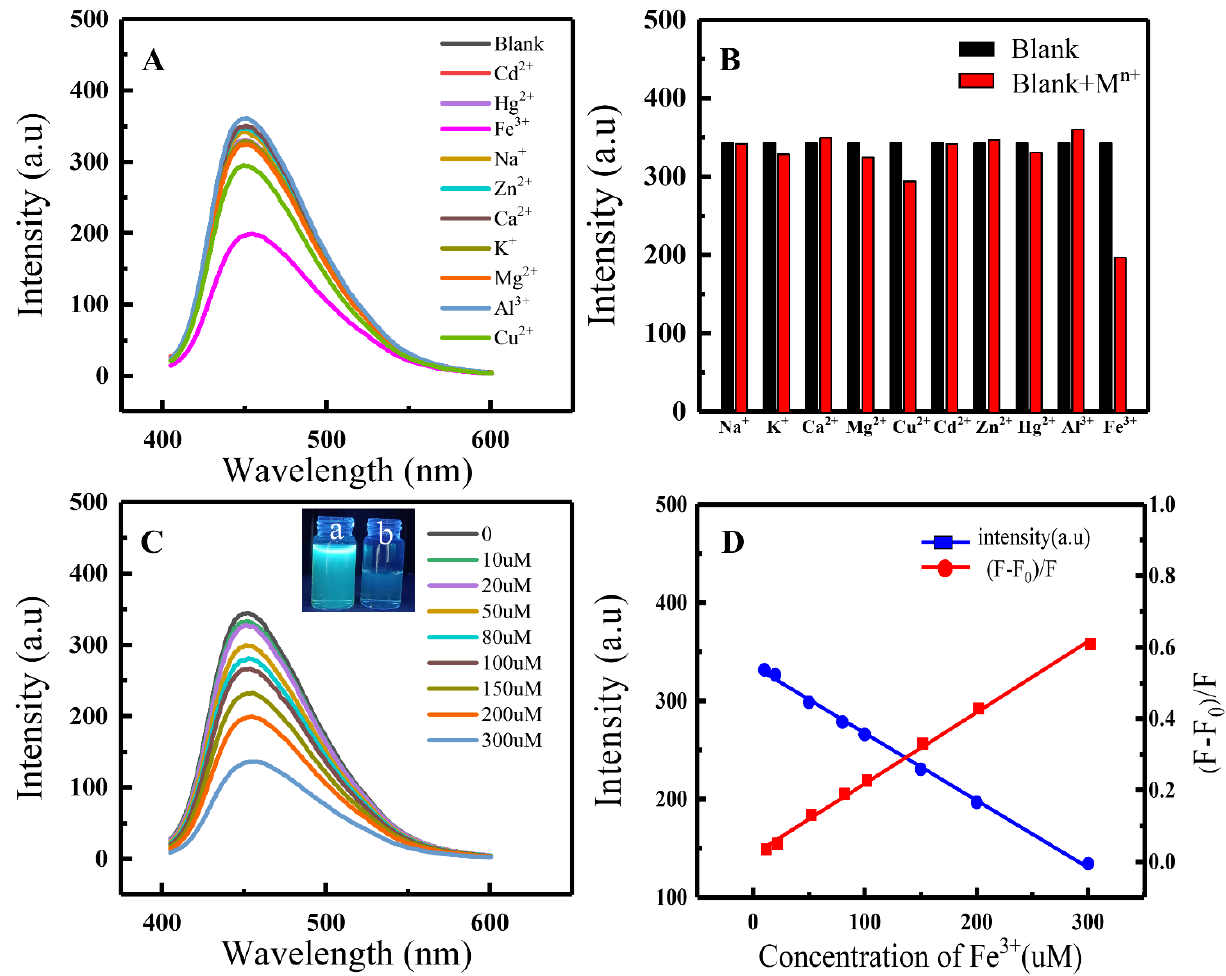
Figure 7. ( A ) Fluorescence intensity curves of metal ions detection (the concentration of the 2.0G PAMAM-DCM PDs is 0.1 mg/mL and all metal ions are 200 μ M). ( B ) The metal ions’ selectivity results. ( C ) Fluorescence-intensity curves of Fe 3+ detection. ( D ) The linear relationship between fluorescence intensity and Fe 3+ concentration. Insets in ( C ) are photographs of (a) 2.0G PAMAM-DCM PDs and (b) 2.0G PAMAM-DCM PDs with 200 μ M Fe 3+ .